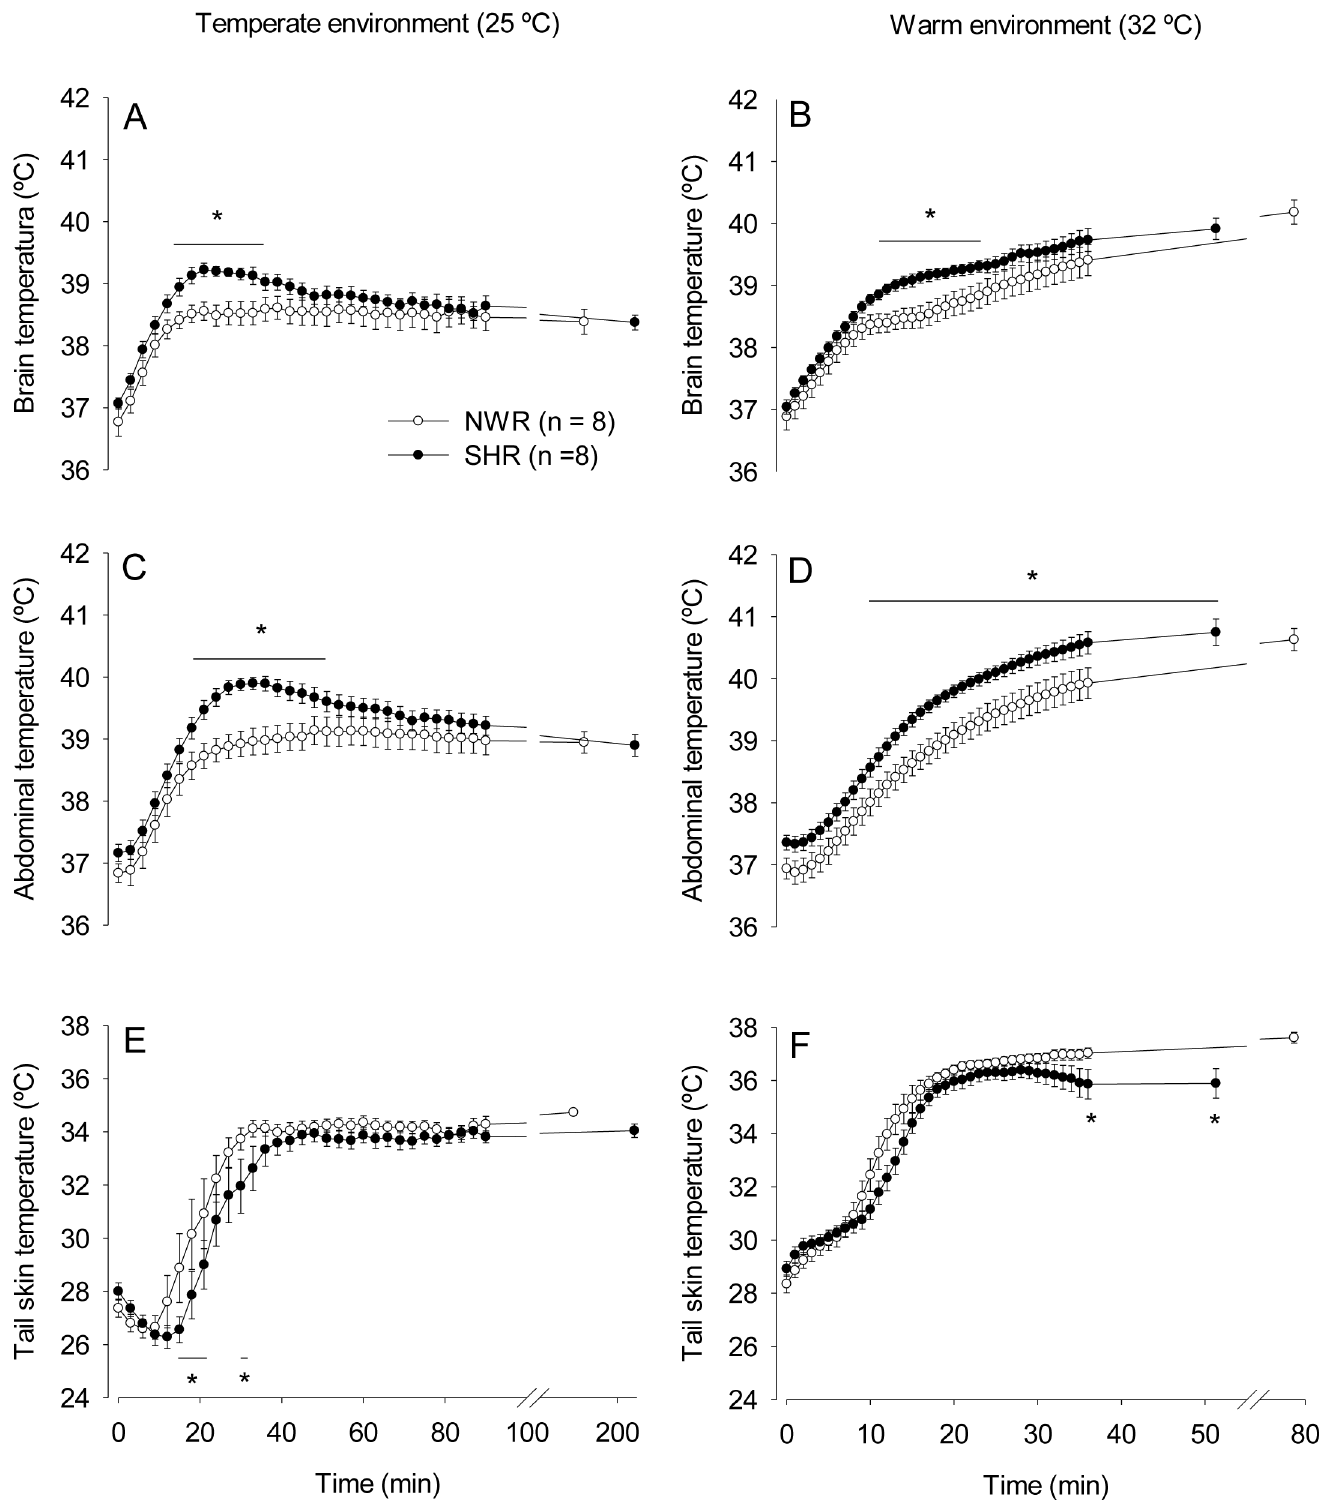
Fig 3. Thermoregulatory responses during constant exercise. Brain (panels A and B), abdominal (panels C and D) and tail skin (panels D and E) temperature in SHRs or NWRs subjected to constant exercise in temperate (panels A, C and E) or warm (panels B, D and F) environments. Data are expressed as the mean ± S.E.M. * p < 0.05 compared with the NWR group in the same environment.